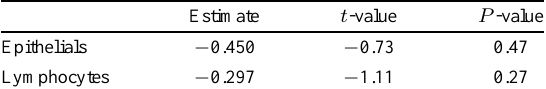
Regression coefficients for cell means with slide age Estimate t -value P -value